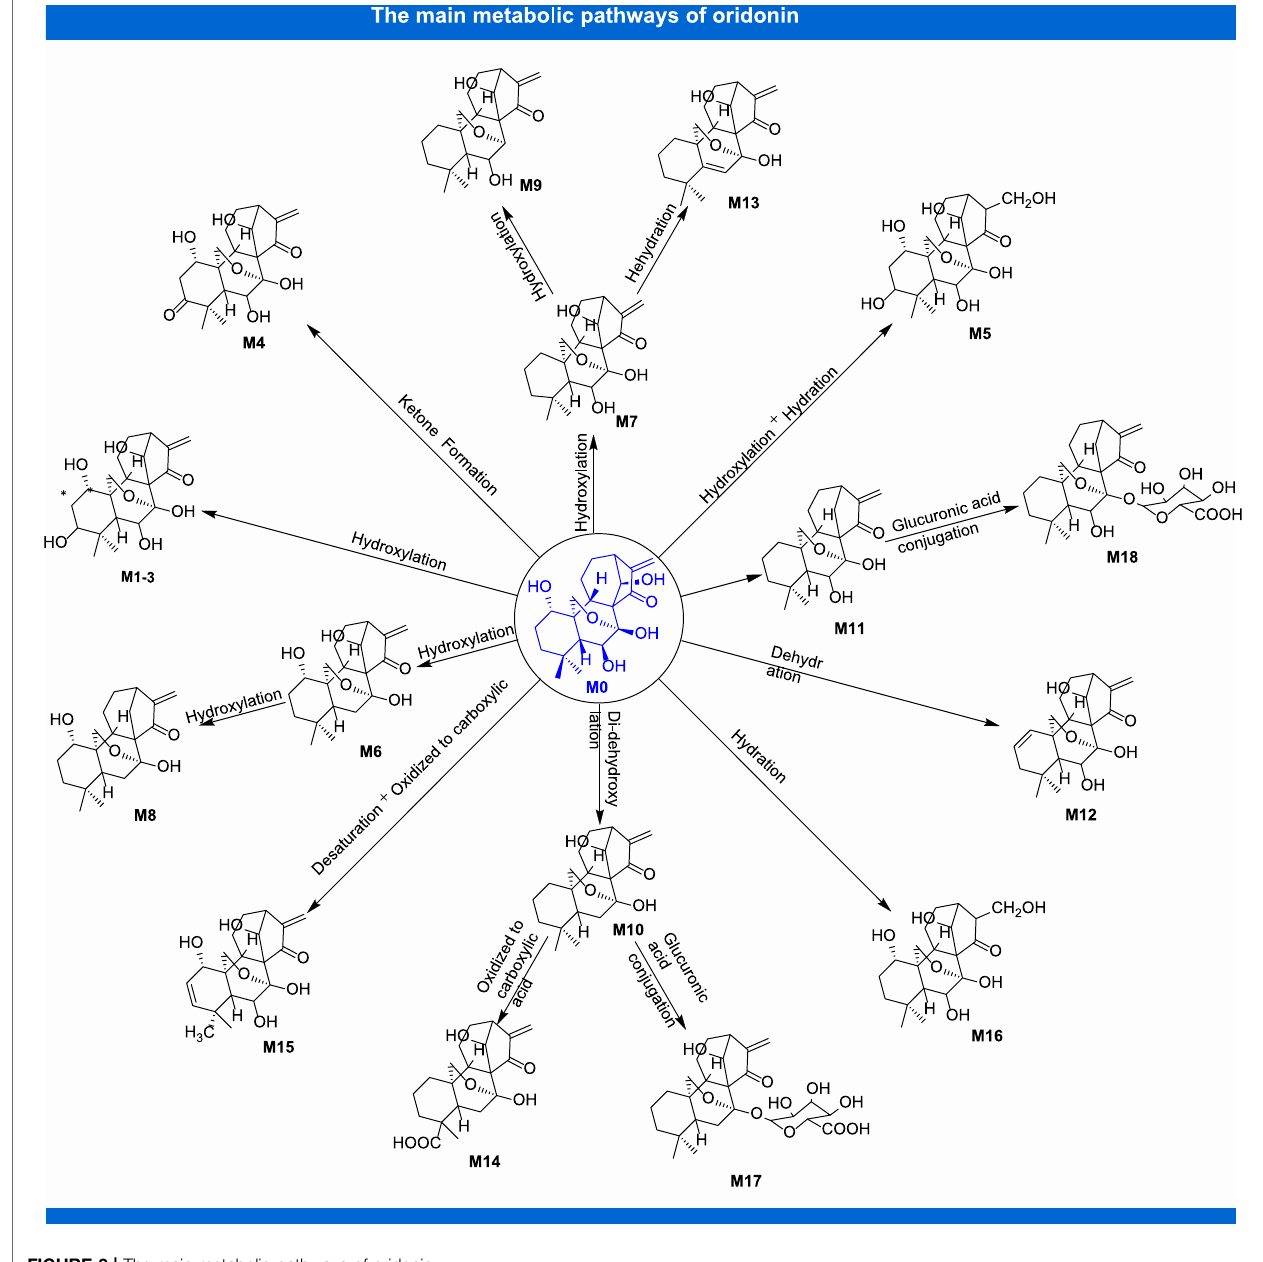
FIGURE 3 | The main metabolic pathways of